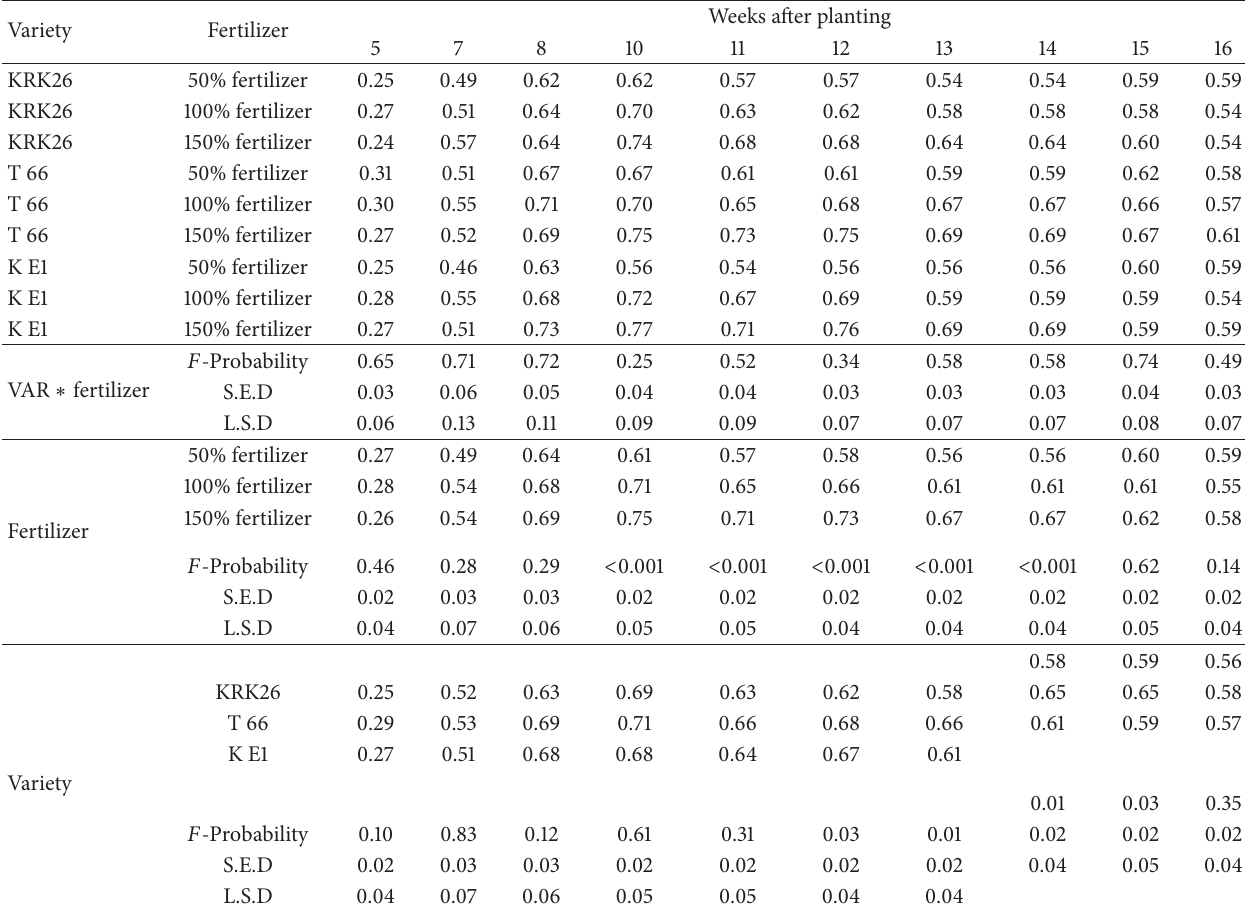
Table 5: The NDVI temporal profiles for the November 15 planted